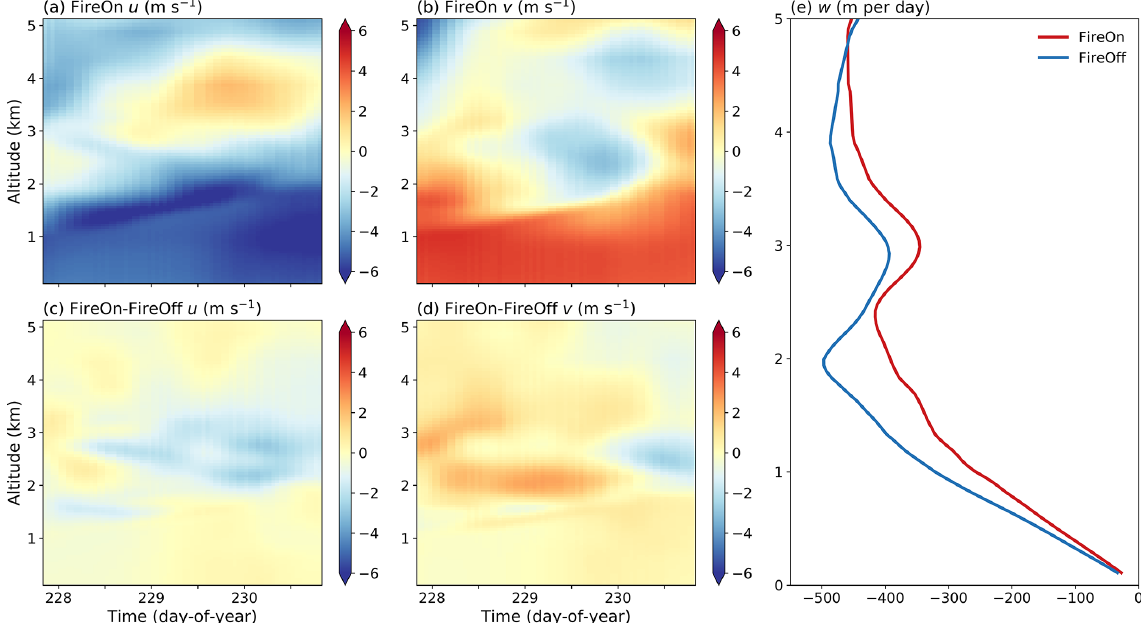
Figure 6. Lagrangian curtains of horizontal winds and averaged profiles of subsidence. Zonal and meridional winds are shown for (a, b) FireOn and (c, d) the FireOn–FireOff difference, respectively. The (e) subsidence profiles are averaged over all